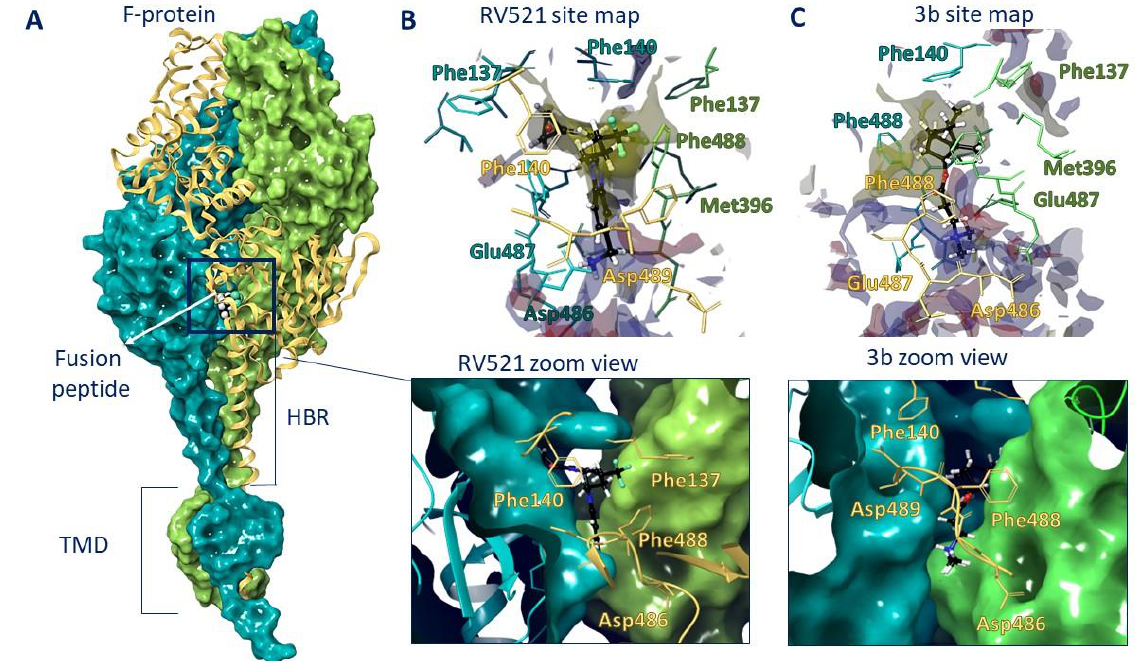
Figure 3. F protein trimer ( A ) with RV521 inhibitor inside. The inhibitor is located between the fusion peptide (a.a. 137–155) and HBR (a.a. 476–524). The binding site maps of RV521 ( B ) and lead compound 3b ( C ) are characterized by hydrophobic (yellow) and donor-acceptor (blue and red) features.